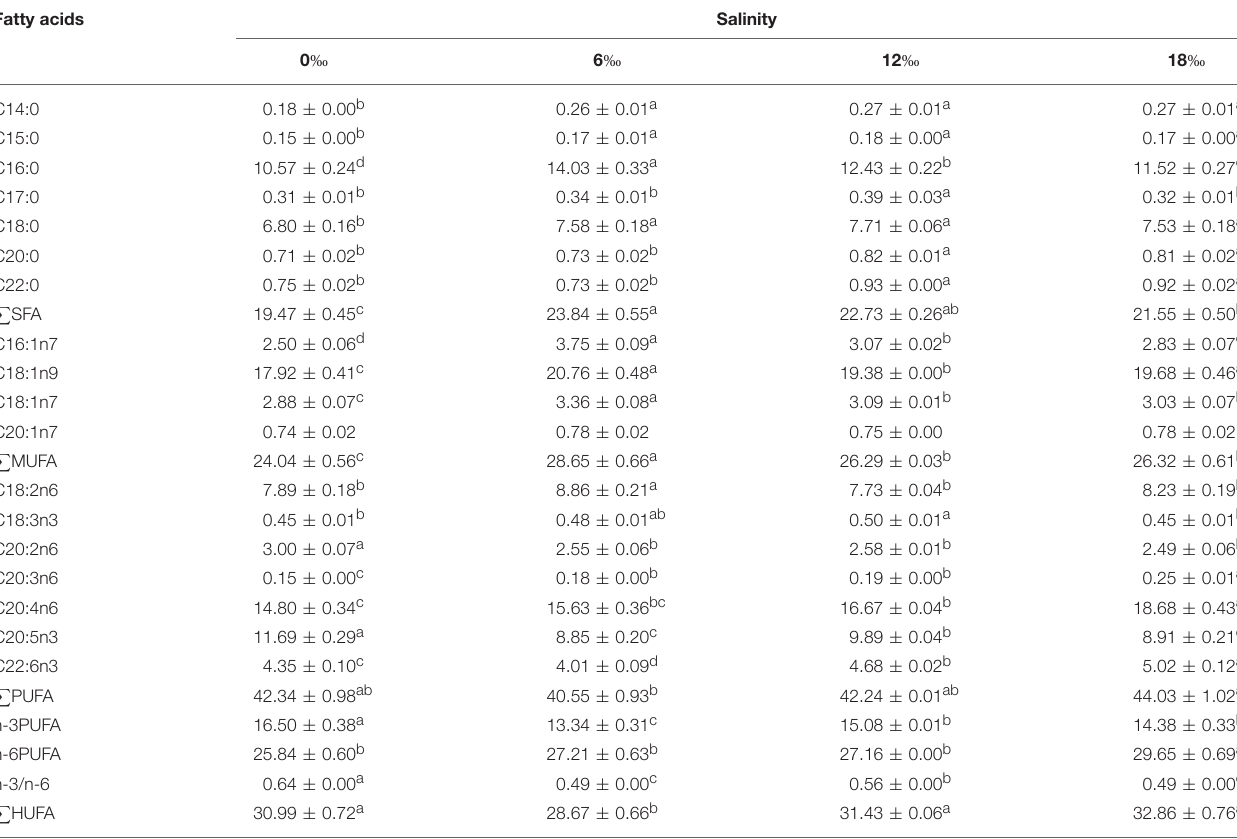
TABLE 4 | Fatty acids profile (% of total fatty acids) in the posterior gills of female E. sinensis subjected to different salinities for 40 days. Fatty acids